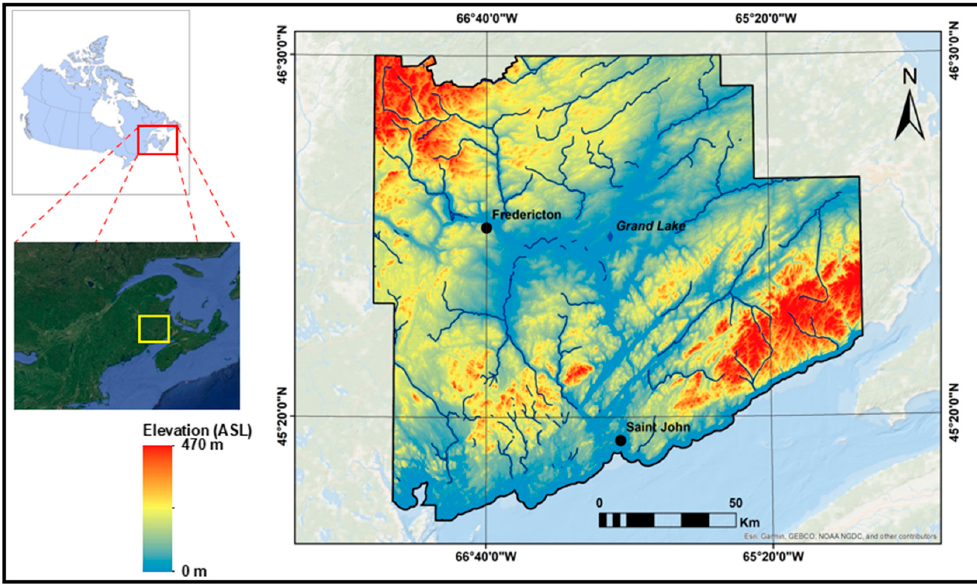
Figure 1. Location of the study area and the corresponding Digital Elevation Model (DEM) and river network.